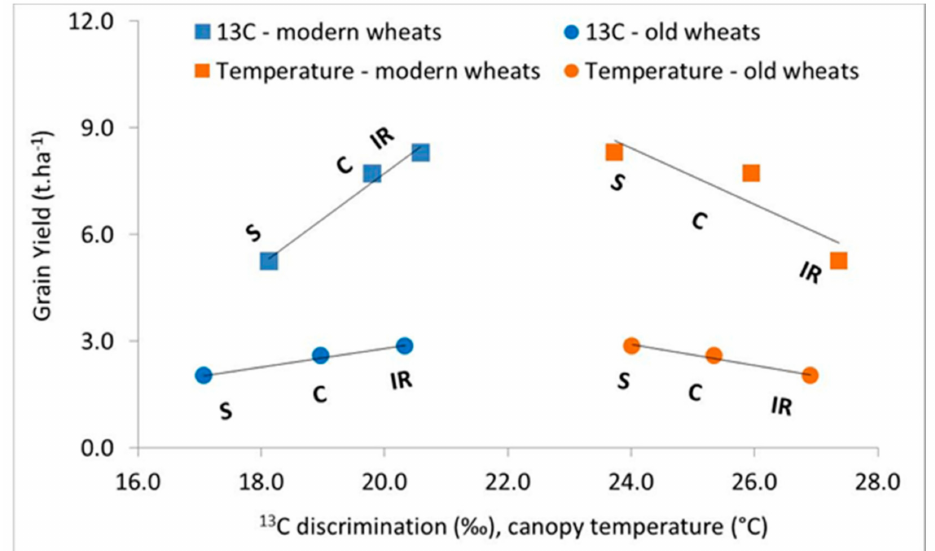
Figure 3. The relationships between grain yield and grain 13 C discrimination or canopy temperature averaged over experimental years. The yield data represent average of experimental years and cultivars; temperature data are averages of two measuring terms, experimental years and